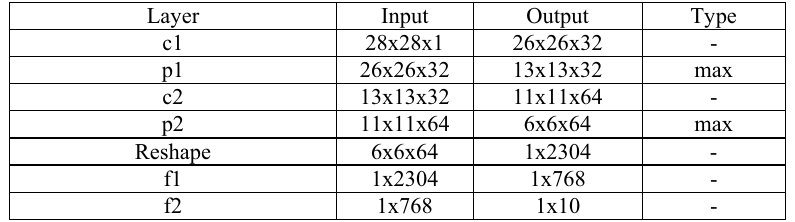
Table 1. (cid:3) Parameters of the model.